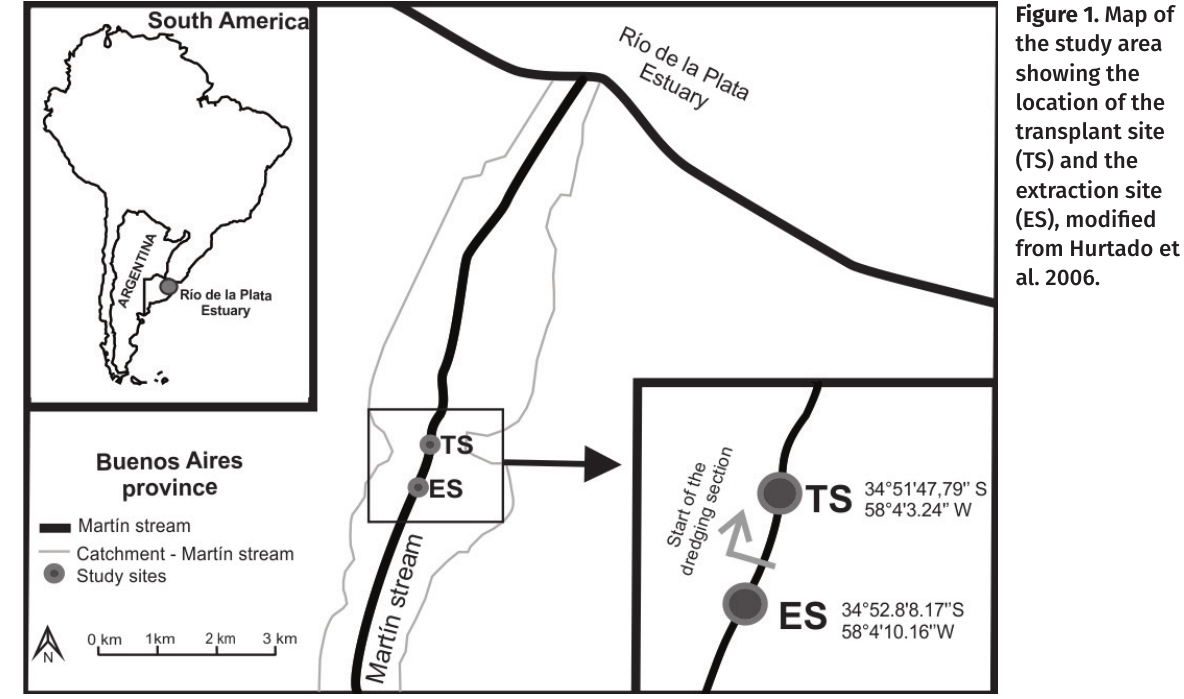
Figure 1. Map of the study area showing the location of the transplant site (TS) and the extraction